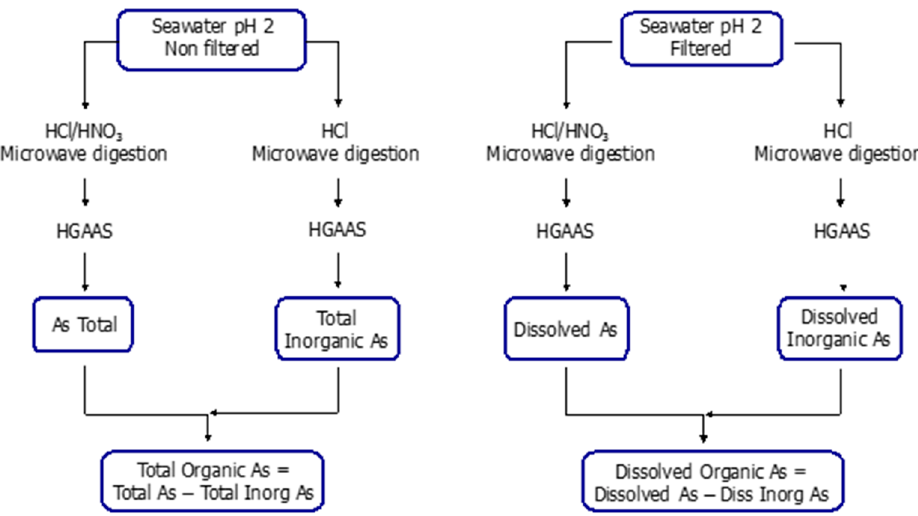
Figure 2. Scheme of chemical fractionation of As in water samples.